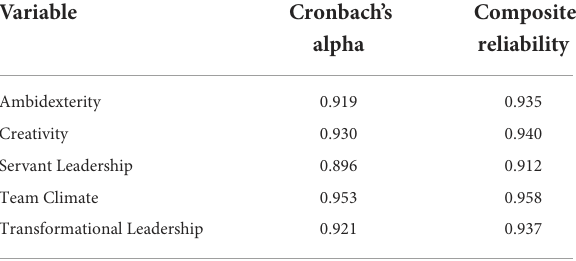
TABLE 5 Cronbach’s alpha and composite reliability.